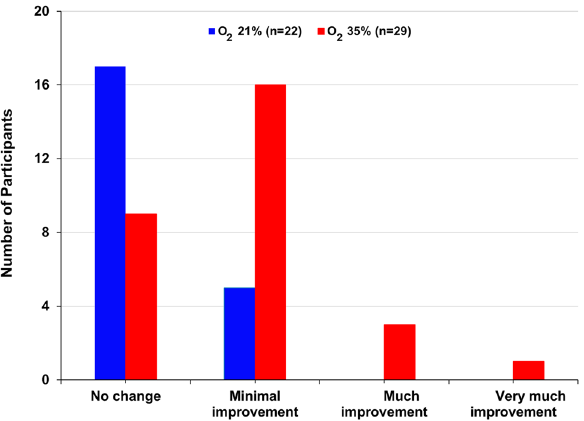
Figure 3. Effect of 35% oxygen treatment on CGI improvement score at 4 weeks. The data are presented as the change from baseline to week four. There were significantly more improved patients in the 35% oxygen treatment group as opposed to the control group, as measured by CGI improvement (Chi-square 11.5, df = 3, P < 0.01).